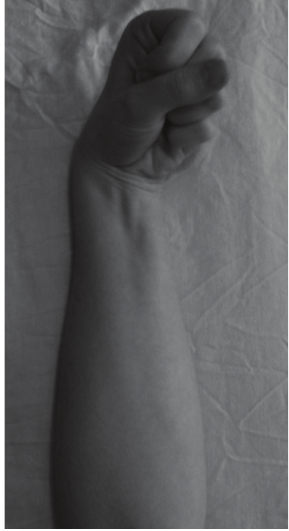
Figure 1: Position of the a ff ected limb.